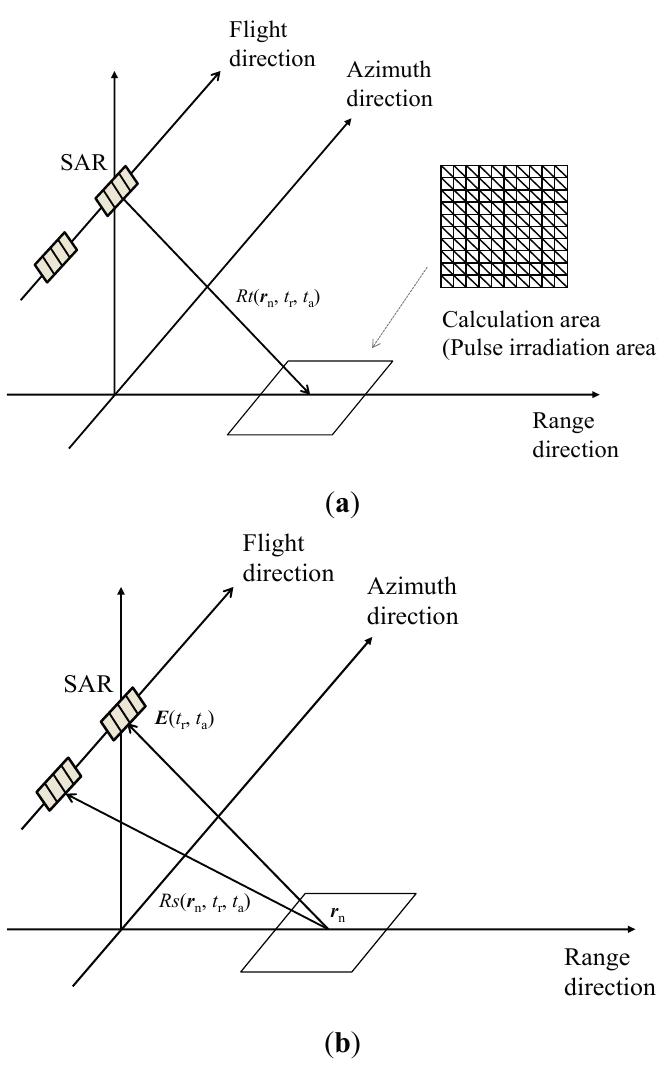
Figure 1. Schematic images of the AT-InSAR simulation. ( a ) transmitted microwave; ( b ) received